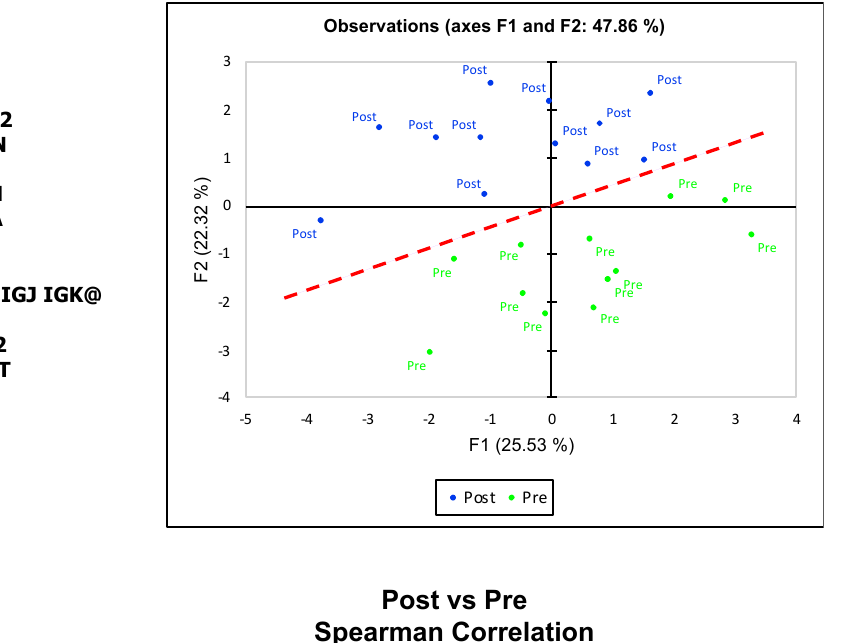
Figure 3. Principal Component Analysis of 11 differentially expressed plasma proteins from HCM patients reveals excellent separation between the preoperative and postoperative samples. Blue circles—post; green circles—pre.